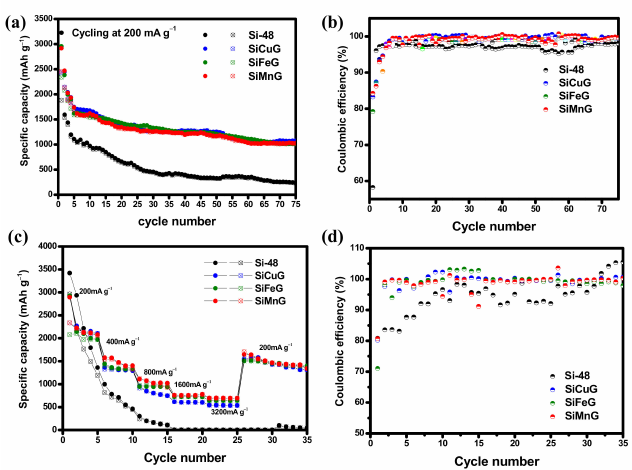
Figure 10. ( a , b ) Cyclability and respective Coulombic efficiency at 200 mA g − 1 in the potential window of 0.01–2.0 V. ( c , d ) Rate capability and respective Coulombic efficiency results at applied currents of 200–3200 mA g − 1 in the potential window of 0.01–2.0 V of Si-48, SiCuG, SiFeG, and SiMnG vs. Li/Li + as counter electrode with 1 M LiPF 6 in EC:DEC:FEC ( v / v ratio of 5:70:25)